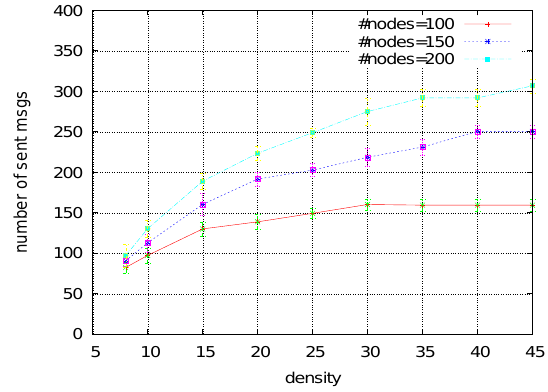
Fig. 8. Average number of messages sent per node with SERENA and OSERENA.